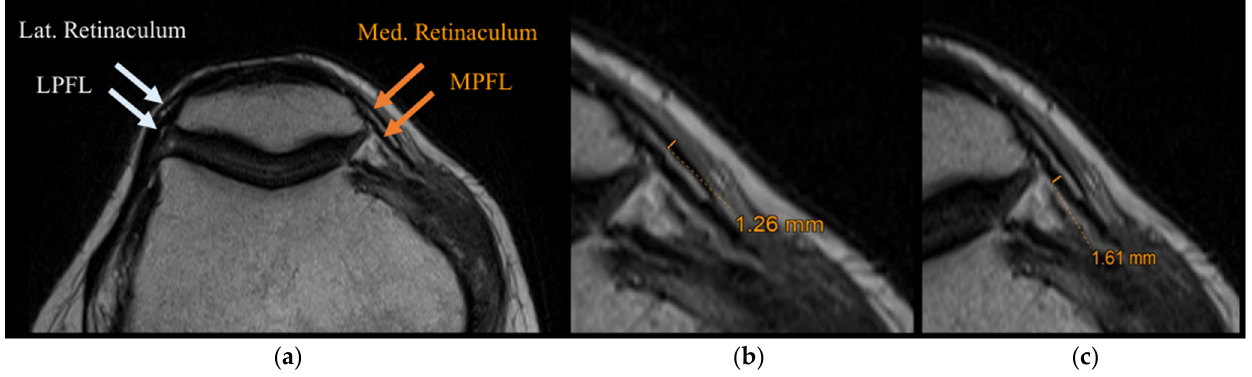
Figure 4. Radiological study: ( a ) MRI with MPFL, medial retinaculum, LPFL, lateral retinaculum indicated; ( b ) measurement of the medial retinaculum; ( c ) measurement of the medial patellofemoral ligament. Table 4. Radiological measurements and statistical analysis of the radiological